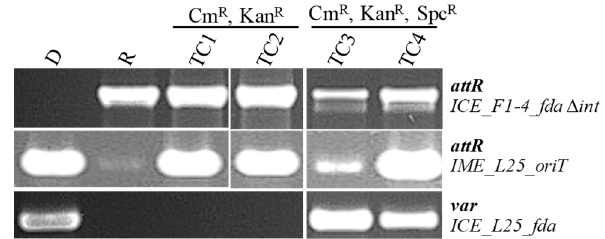
Figure 3. PCR analysis of four transconjugants (TC1 to TC4) obtained using the mating pair S. salivarius L25(ICE_ SsalL25_fda ::IME_ SsalL25_oriT ) (donor D) / S. salivarius F1-4(ICE_ SsalF1-4_fda ∆ int ) (recipient R). Specific regions were amplified to discriminate the elements attR for ICE_ SsalF1-4_fda ∆ int and IME_ SsalL25_oriT and the region of ICE_ SsalL25_fda that includes accessory genes (di ff erent from the one of ICE_ SsalF1-4_fda ), indicated as var in the figure. Resistance phenotypes of the transconjugants are indicated above the wells: Cm R , chloramphenicol resistance (conferred by ICE_ SsalF1-4_fda ∆ int ); Kan R , kanamycin resistance (conferred by IME_ SsalL35_oriT ); and Spc R , spectinomycin resistance (conferred by ICE_ SsalL25_fda ).